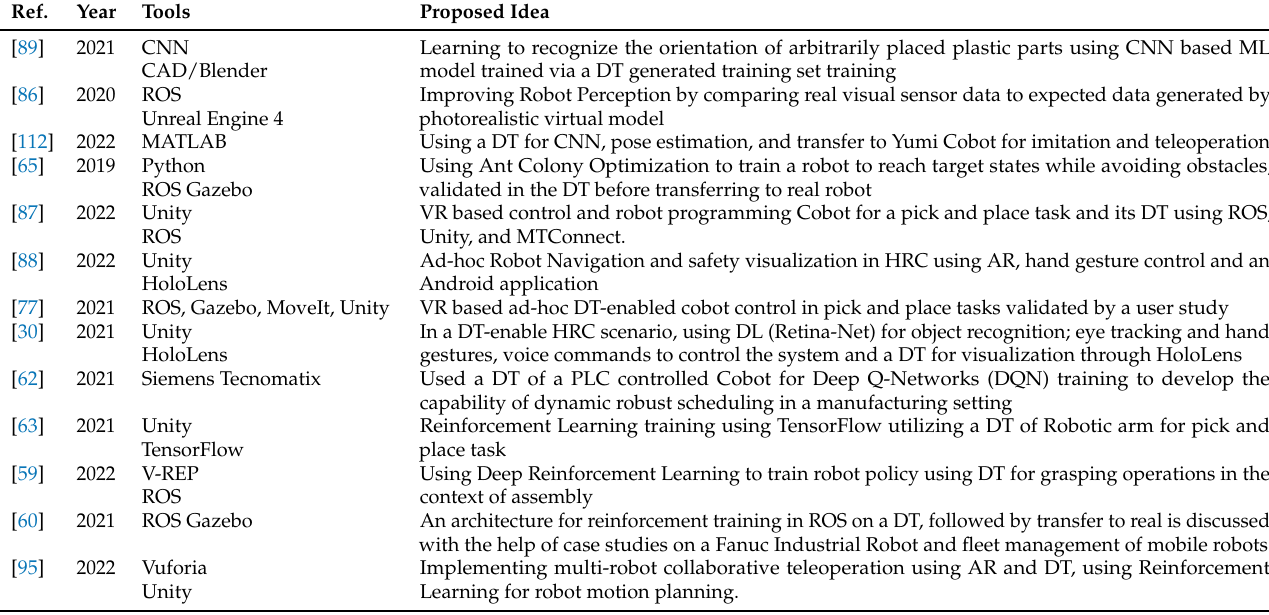
Table 5. Applications in Training of Robotics